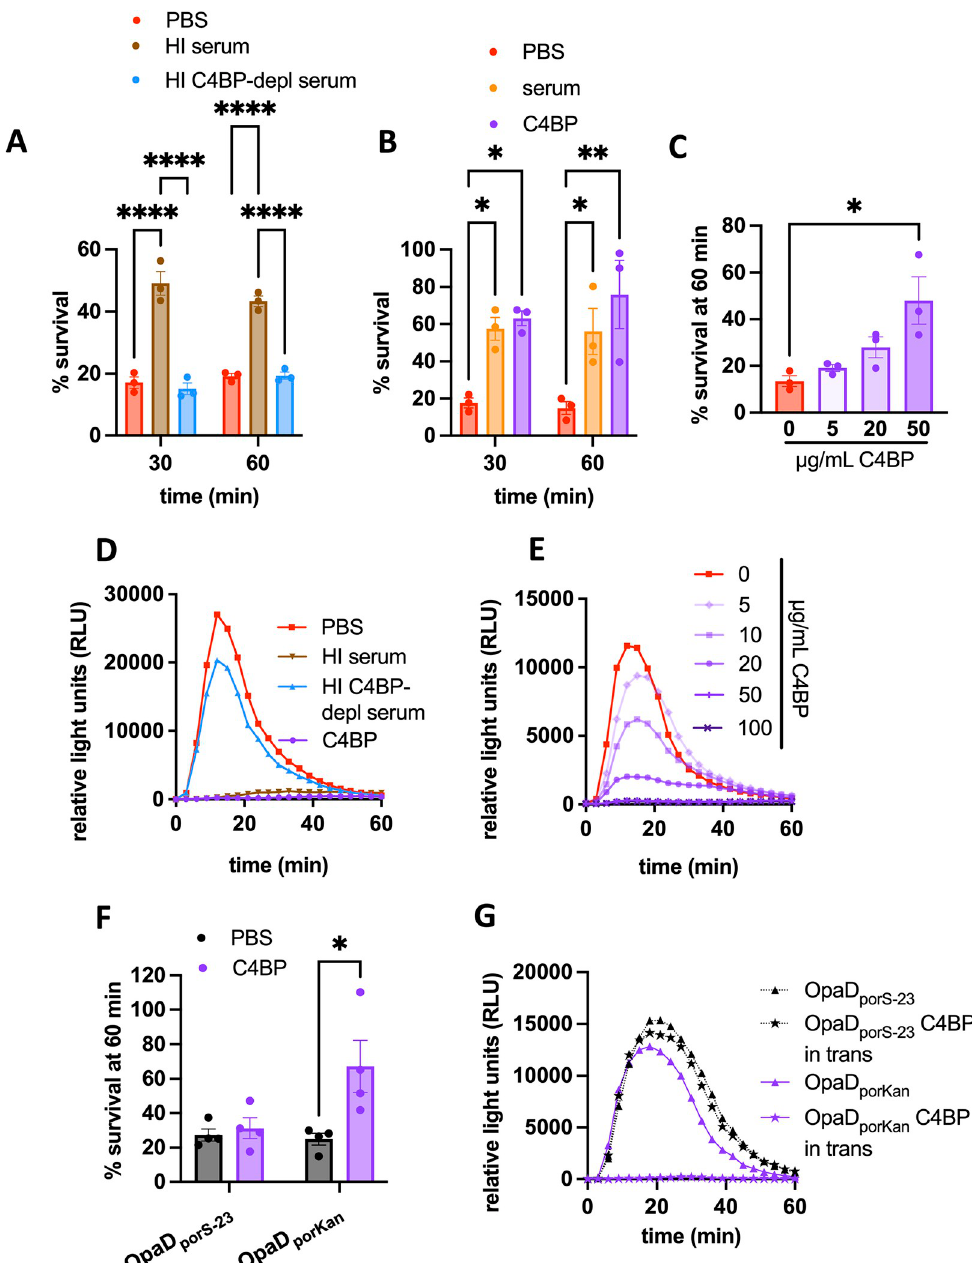
Fig 4. C4BP is necessary and sufficient for serum-mediated suppression of neutrophil anti-gonococcal activity. (A-C) Adherent, IL-8-treated neutrophils were exposed to OpaD+ Gc incubated in PBS+ (red) or the following (all at 25% final concentration) as in Fig 1A: (A) heat inactivated serum that was C4BP-replete (brown; Lund University) or C4BP-depleted (depl, blue); (B) C4BP-replete serum (orange; Lund Universtiy) or 50 μ g/mL purified C4BP (purple); (C) C4BP at the indicated concentrations. In (A-B), two-way ANOVA with Sidak’s post-hoc test was used to compare each condition within each time point for 3 independent experiments; (C) used one-way ANOVA followed by Tukey’s post-hoc comparisons to compare each condition to PBS alone (0 μ g/mL C4BP). (D-E) Neutrophil ROS production was measured as in Fig 1C in response to OpaD+ Gc that was incubated (D) in PBS, heat-inactivated C4BP-replete serum (brown; Lund University), heat inactivated C4BP-depleted serum (blue), or purified C4BP at 50 μ g/mL (purple); or (E) in the indicated concentration of C4BP. (F) Neutrophils were exposed to OpaD porS-23 Gc or OpaD porKan Gc, with or without C4BP addition to the infection milieu (50 μ g/mL), and bacterial survival after 60 minutes was measured as in (A). Results are the mean ± SEM of 3 independent experiments; two-way ANOVA with Sidak’s post-hoc comparisons were used to compare each condition. � p < 0.05, �� p < 0.01, ���� p < 0.0001. (G) OpaD+ Gc (grey solid lines), OpaD porS-23 Gc (black dotted lines),